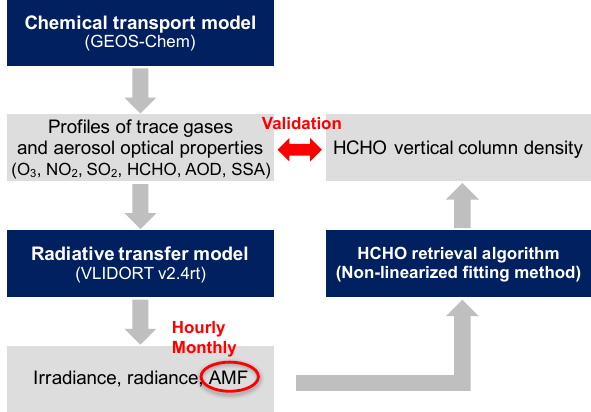
Figure 1. Schematic diagram of observation system simulation ex- periments (OSSE) used to validate our retrieval algorithm and to examine its sensitivity to the temporal variation of AMF values. GEOS-Chem, driven by assimilated meteorological data, is used to produce profiles of atmospheric constituent concentrations. VLI- DORT calculates observed radiances measured by geostationary satellites using atmospheric constituent concentrations and mete- orological conditions from GEOS-Chem simulations. The HCHO retrieval algorithm is developed based on least-squares fitting of a non-linearized Lambert–Beer model and is validated by compar- isons between simulated and retrieved column densities of HCHO. The latter are obtained by applying the retrieval algorithm to the ob- served radiances from VLIDORT. Details are provided in the text.